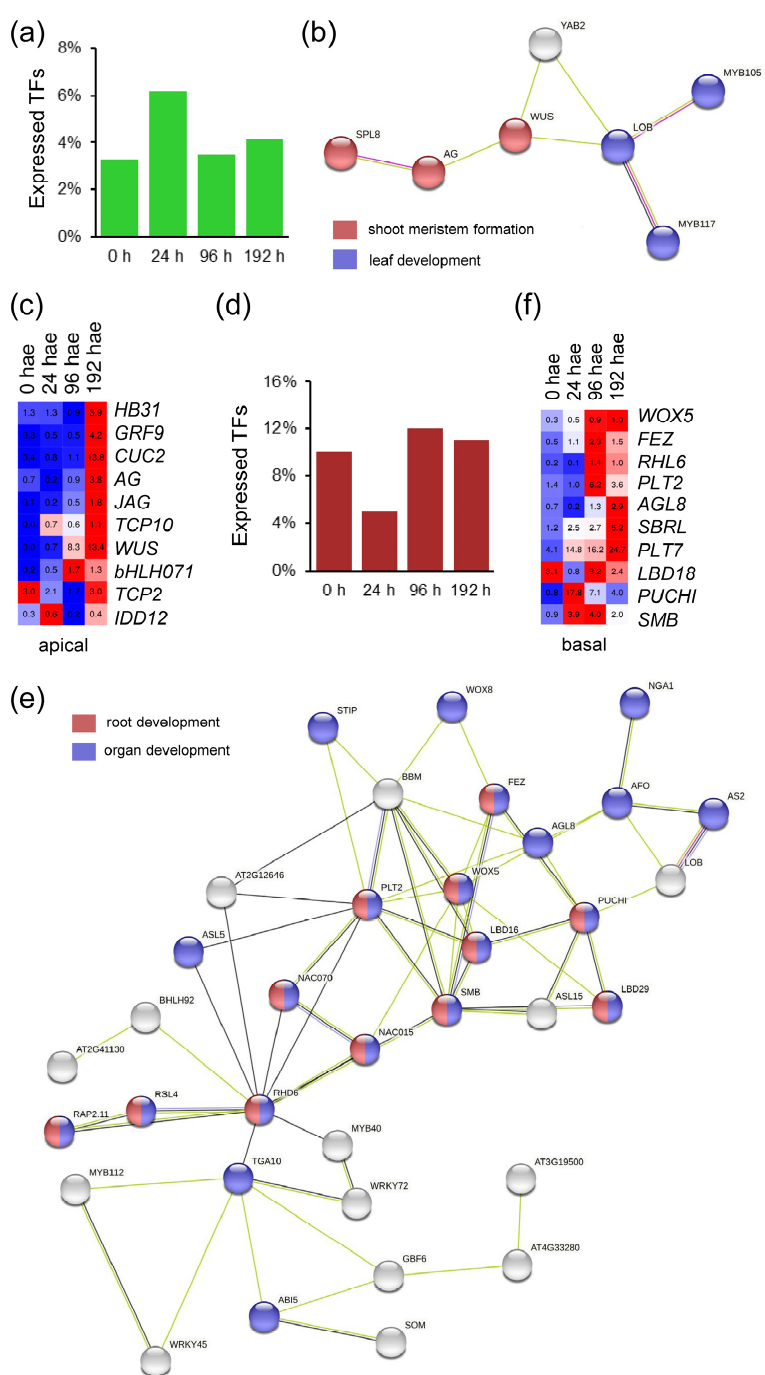
Figure 1. Region-specific TFs identified during de novo organ formation in tomato hypocotyl explants after wounding. ( a ) Percentage of TFs specifically expressed in the apical region of the hypocotyl over time. ( b ) STRING interaction network of A. thaliana orthologs of tomato TFs expressed specifically in the apical region of the hypocotyl. ( c ) Heatmap of selected TFs expressed in the apical region of the hypocotyl explants. ( d ) Percentage of TFs specifically expressed in the basal region of the hypocotyl over time. ( e ) STRING interaction network of A. thaliana orthologs of tomato TFs expressed specifically in the basal region of the hypocotyl. ( f ) Heatmap of selected TF expressed in the basal region of the hypocotyl explants. Blue/white/red in c and f indicate normalized counts per million reads mapped (cpm) values in each row, where red indicates the highest abundance of transcripts. Gene annotations are found in Table